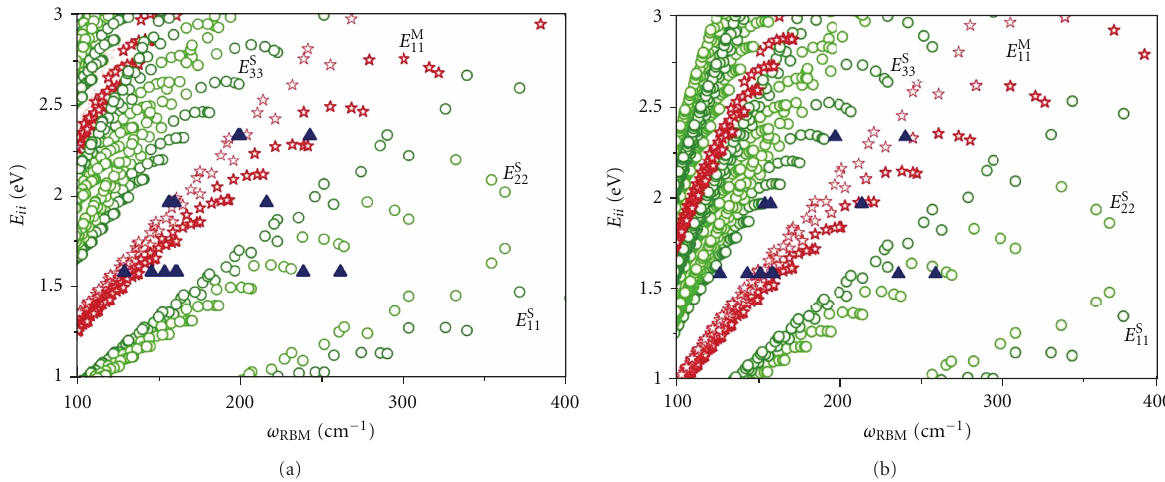
Figure 2: Optical transition energies ( E ii ) of each ( n , m ) SWNT plotted versus the respective RBM frequencies ( ω RBM ), known as the Kataura plot [39]. The optical transition energies of semiconducting (circles) and metallic (stars) SWNTs are shown. Up triangles represent RBM results obtained from resonance Raman spectroscopy, taken from SWNTs deposited on crystalline miscut quartz [23]. The y -axis for these up triangles coordinates is chosen by considering resonance at E ii ≈ E laser . The x -axis is chosen by considering a correspondence between d ω ω = 227 /d t [40], and E ii from (1); (b) Equation (2) with C = 0 . 082 nm − 2 and a 100 meV downshift t : (a) the standard relation RBM and RBM in E ii with respect to the values in (a) (adapted from [41]).